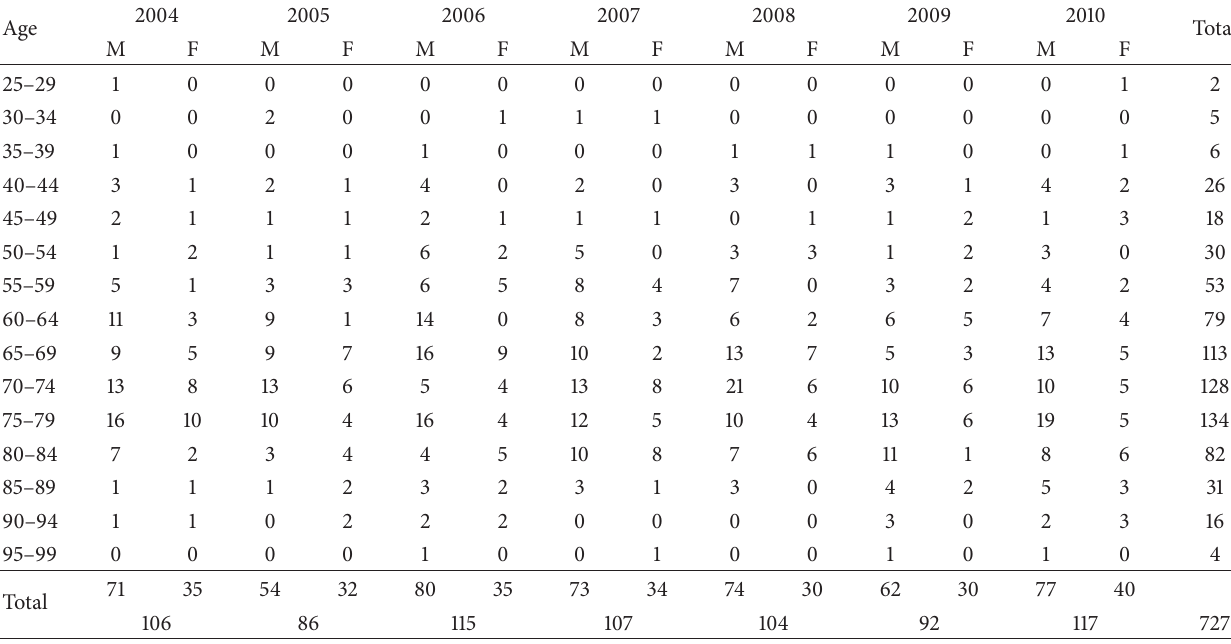
Table 2: Deaths by lung cancer as the underlying cause in Chihuahua City in population older than 25 years.